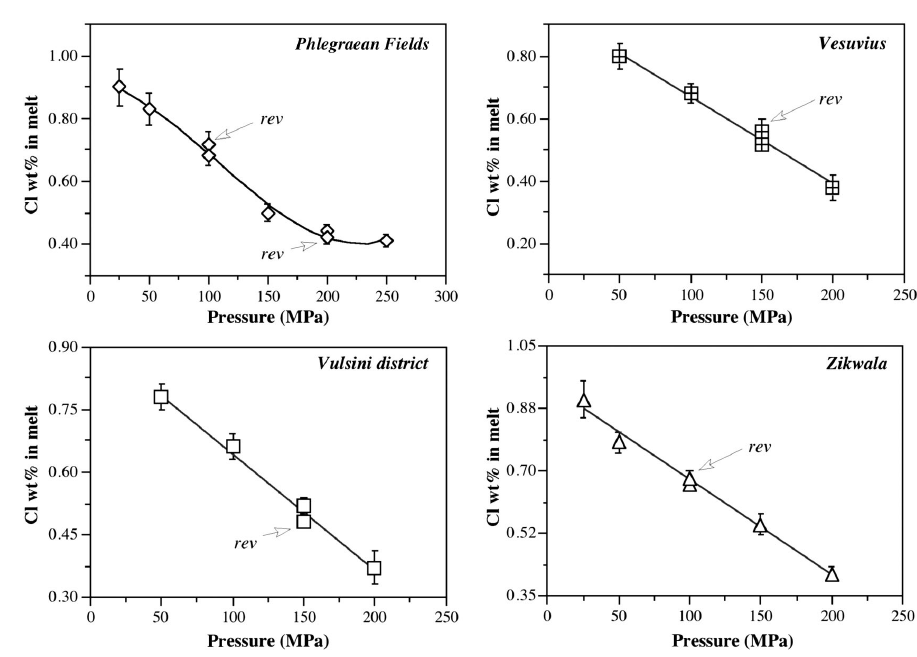
Fig. 4. Chlorine solubility ( ± 1 σ standard deviation) in trachytic (Signorelli and Carroll, 2002) and phonolitic melts (Signorelli and Carroll, 2000) saturated with aqueous fluid+brine versus pressure. «This study» refers to Signorelli and Carroll (2002). Original melt compositions are given in table I and «rev» refers to reversal exper-